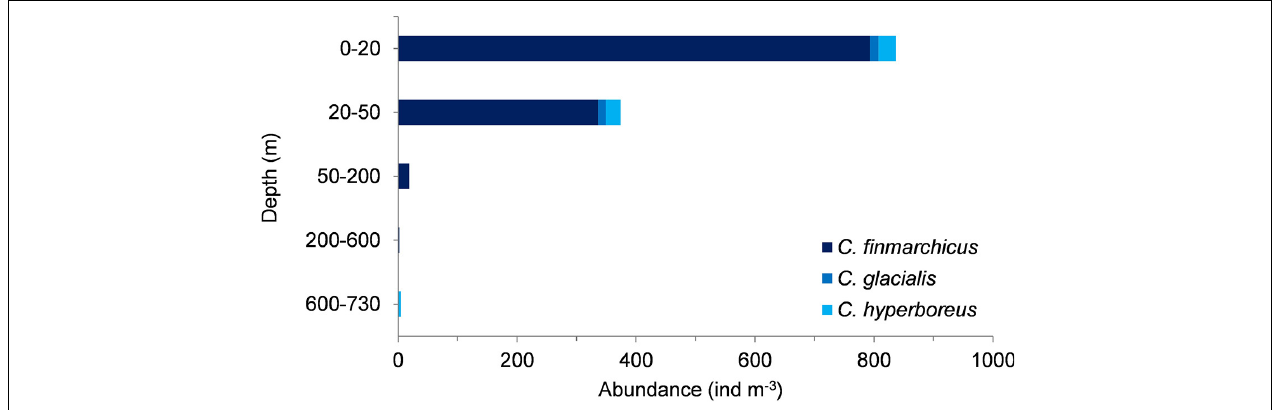
FIGURE 7 | Abundance (ind. m − 3 ) of Calanus nauplii sampled with MPS from bottom to surface in five depth layers on 16 June, 2015. Species composition estimated from genetically identified samples collected with MultiNet from the same depth layers immediately after the community samples ( Figure 3 ).